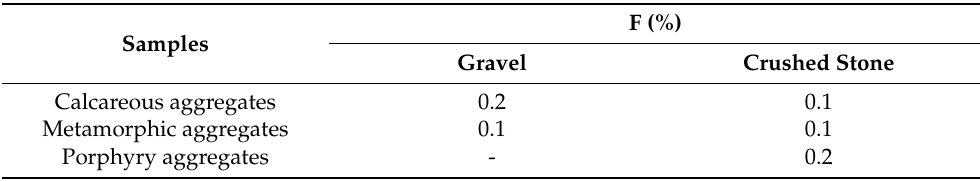
Table 14. Resistance-to-freezing/thawing values (F, expressed in percentage) of the aggregates analyzed